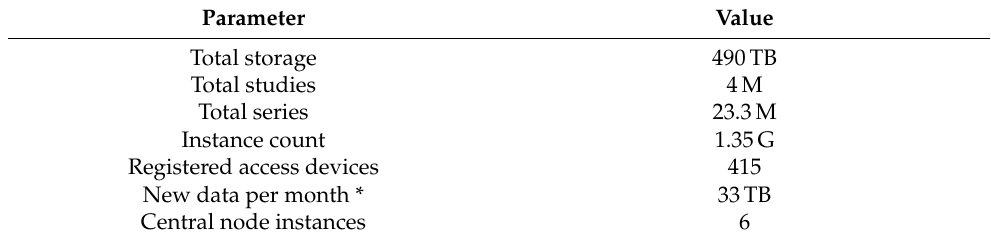
Table 2. Cloud PACS state as of October, 2022. Parameter